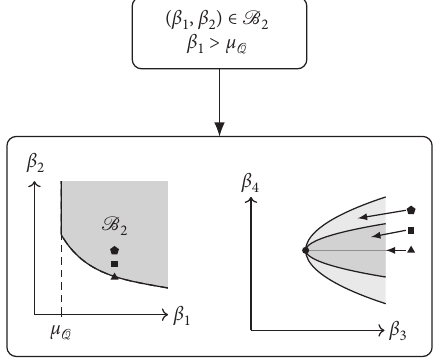
Figure 10: Illustration of Corollary